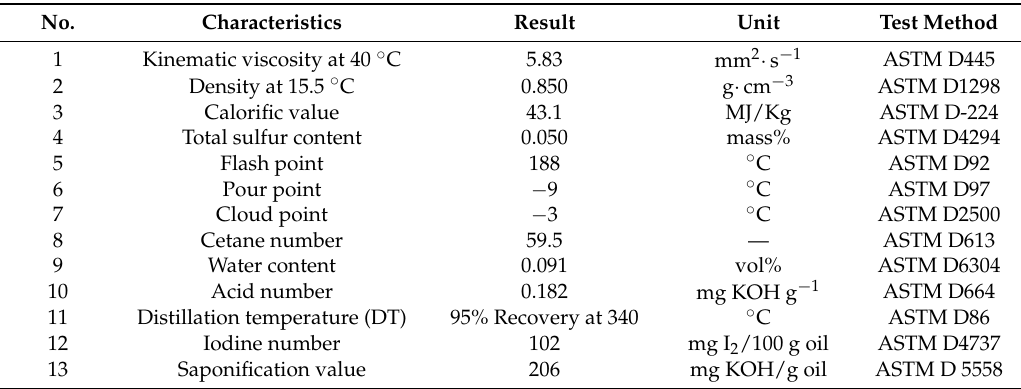
Table 4. Physicochemical properties of the produced